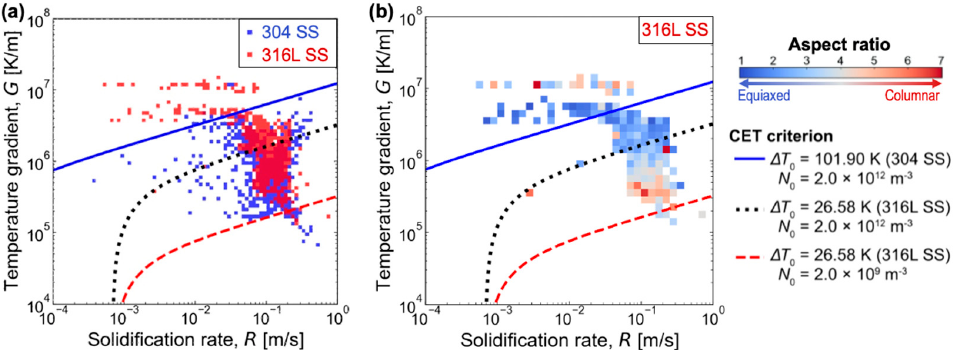
Figure 14. Comparison between solidification conditions (dots and squares) evaluated by CtFD simulation and CET criteria (lines) calculated by Equation (1) with the values of Δ T 0 for 304 SS and 316L SS and those of assumed N 0 . ( a ) dots are colored by the type of steel 304 SS (blue) and 316L SS (red). ( b ) each square is colored by the average aspect ratio of grains in 316L SS for the range of solidification condition indicated by its area.